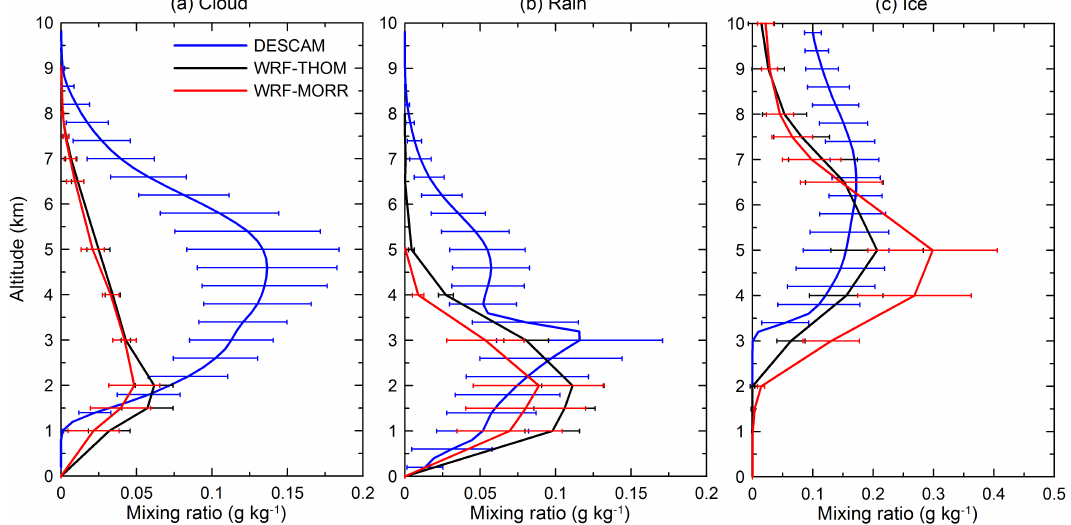
Figure 7. Mean vertical profiles of the mixing ratio of cloud ( a ), rain ( b ) and ice ( c ) obtained over the innermost domain between 07:00 and 12:00 UTC with DESCAM, WRF-THOM and WRF-MORR simulations. The mean profiles are given with ± 1 standard